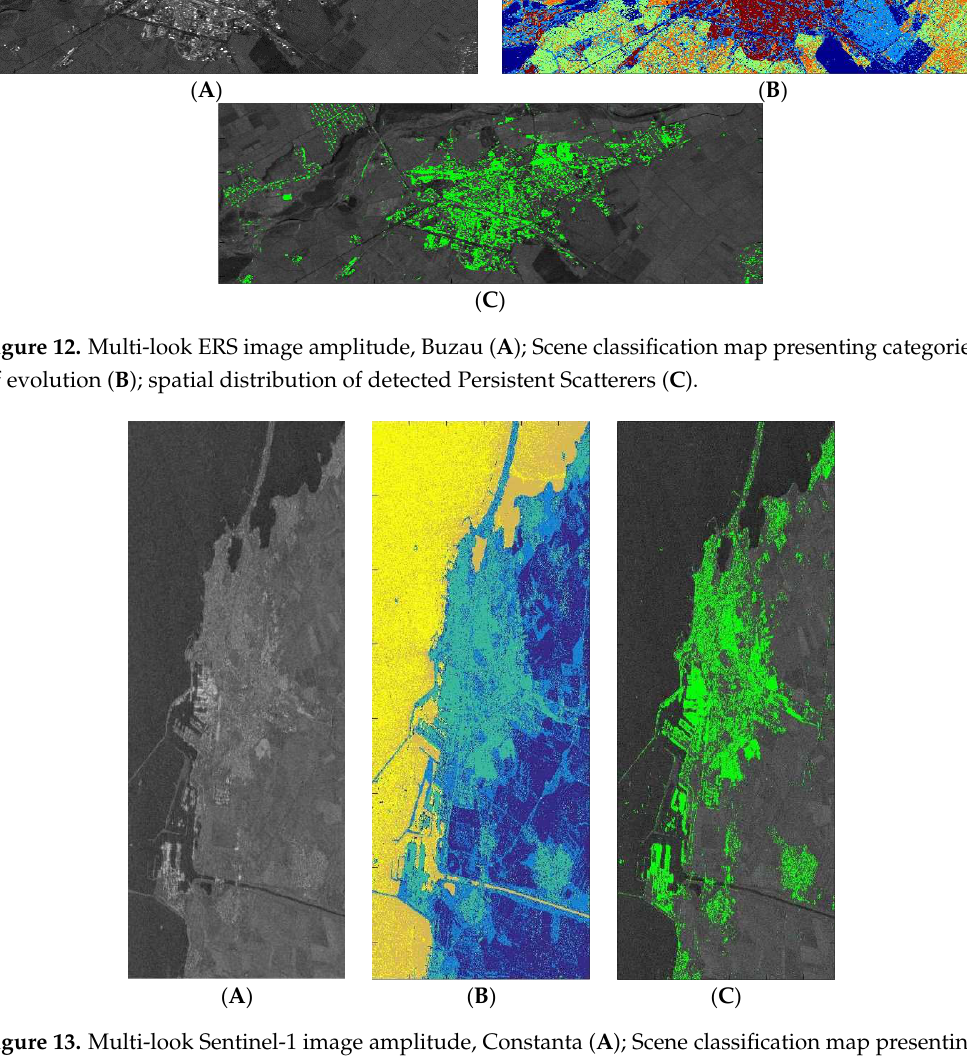
Figure 14. Perplexity curves for ERS dataset. The inflection point — 27 (for Single-Look) and 26 (for Multi-Look).